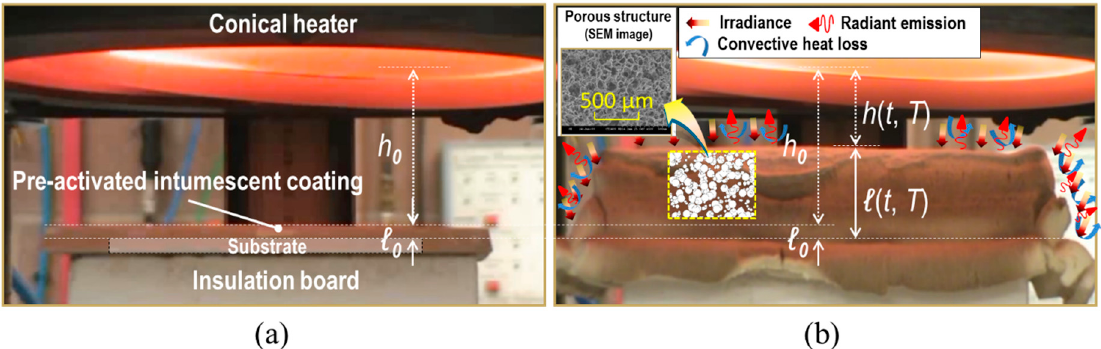
Figure 1. Thermo-physical behaviour of an inorganic-based intumescent coating tested with cone calorimetry: ( a ) in the initial state and ( b ) in the fully-expanded state, where ℓ , h , and SEM refer to the thickness of the coating, the distance between the heater and the coating’s exposed surface, and scanning electron microscopy while the subscript 0 indicates the initial state.